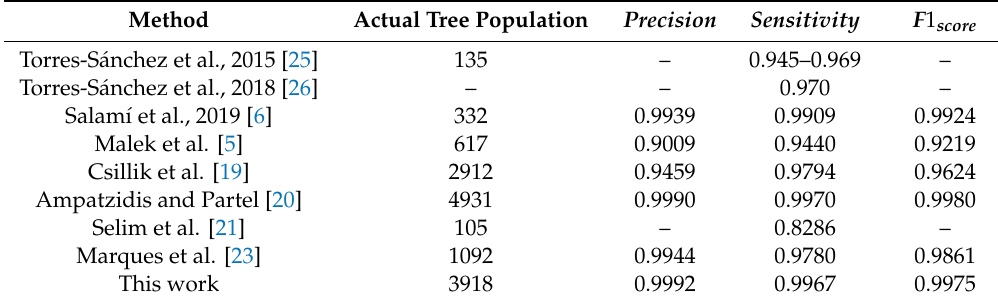
Table 3. Comparison of performance of di ff erent methods for crop trees counting published in the bibliography, and the present